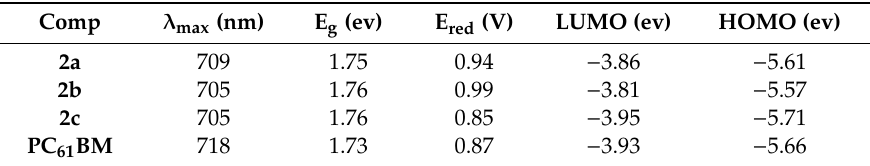
Table 1. Optical bandgap, onset reduction, and lowest unoccupied molecular orbital / highest occupied molecular orbital (LUMO / HOMO) energy levels of the open-cage 2a – c and compound 3 . Comp λ max